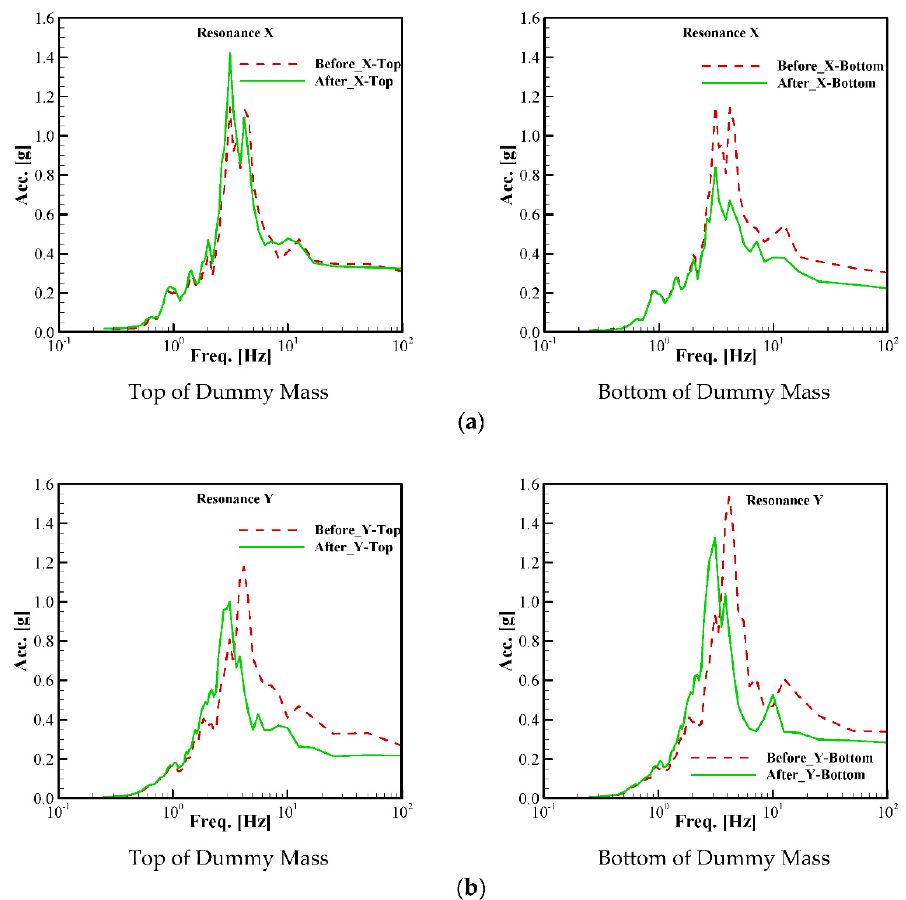
Figure 10. Peak response correlation affected by LRB damage: ( a ) resonance response in the X-direction; ( b ) resonance response in the Y-direction.